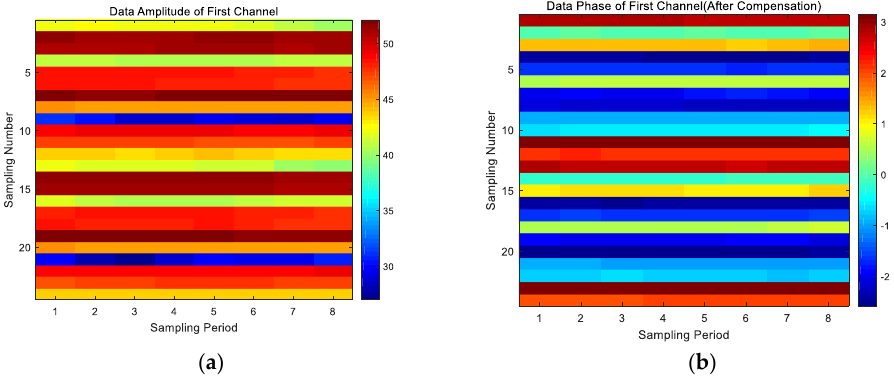
Figure 6. Amplitude and phase of the single–-frame data after compensation. ( a ) Amplitude after compensation. ( b ) Phase after compensation.